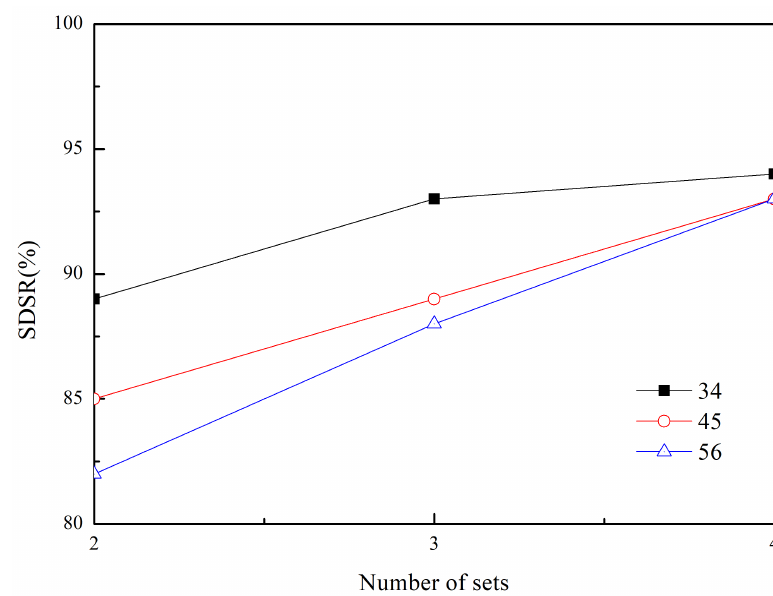
Figure 8. SDSR in (2,3)-firm application as a function of ( m , k )-firm